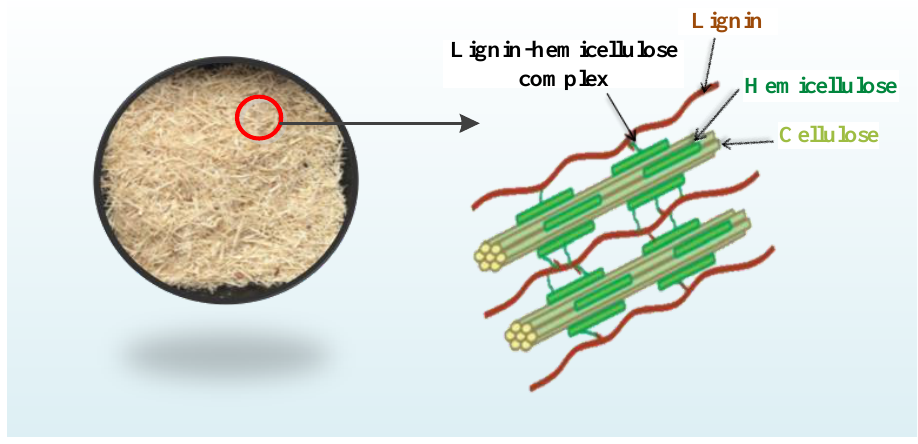
Figure 1. Three-dimensional structure of cellulose, hemicellulose, and lignin in bagasse. Hemicellulose glycans can be dissolved in alkaline solution or hydrolyzed by dilute acid. The commonly used methods for hemicellulose separation include dilute acid hydrol- ysis, alkali extraction, hydrothermal extraction, and organic solvent extraction.